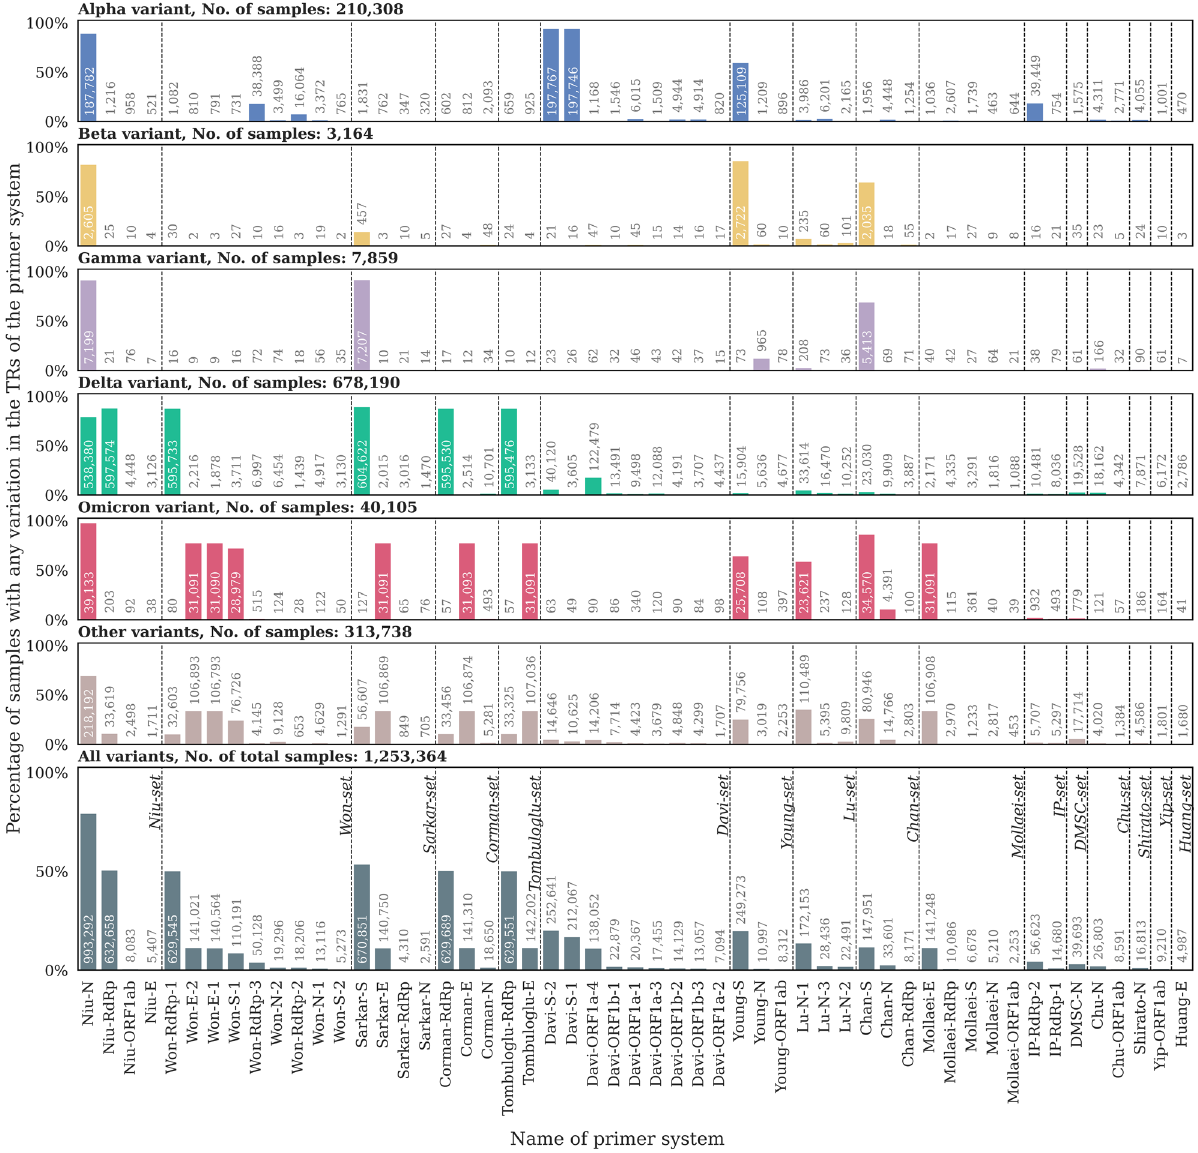
Figure 2. Percentage and number of samples with any mutations in the TRs of a given primer system, colored by WHO designation. Primer system names are based on the nomenclature: [first author last name]-[target gene name]-[id, when multiple primer systems target the same gene]. Samples with no variants in the given TRs are not contained at least three mutations, with one of the samples presenting seven variant positions. Another primer system with TRs commonly containing multiple mutations is the Sarkar-S system, for which 43,870 samples had more than one genomic variant. On the other hand, none of the samples had multiple mutations in the TRs of the Mollaei-ORF1ab system and the number of samples (2253) containing a single mutation was also exception- ally low. As a next step, we examined the type of the detected variants and their location in the TRs of different primer systems and categorized them as either “high risk” or “moderate risk” mutations (see “Methods” for details). 0.015% to 50.30% of the samples contain high risk mutations for a particular primer set. The distribution of samples with variants belonging to different risk-categories is presented in Fig. 3b. Most of the samples that had any mutations in the TRs of any given primer system contained only variants with no drastic effect on PCR effi- ciency based on their location. For example, the highly mutation-prone TRs of the Niu-N primer system usually contain variants at moderately risky positions which are unlikely to disrupt the PCR process. In contrast, the TRs of two primer systems (Niu-RdRp and Corman-RdRp) are mutated in high risk positions in many samples, comprising around 50% of the total samples analyzed. Based on our results, the most common high and moderate risk mutations that were identifiable in the major- ity of samples are listed in Table 3.